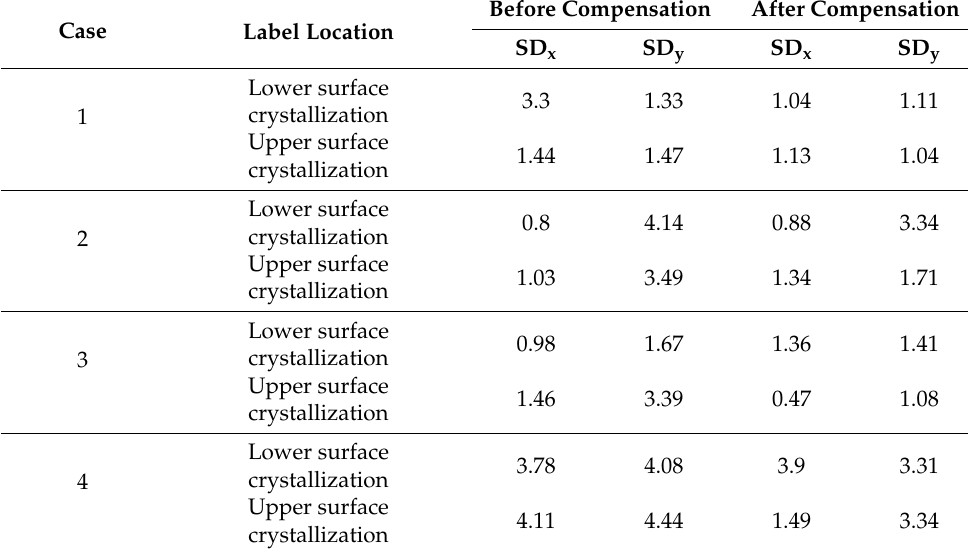
Table 4. Standard plants (in x- and y-axis) before and after progress